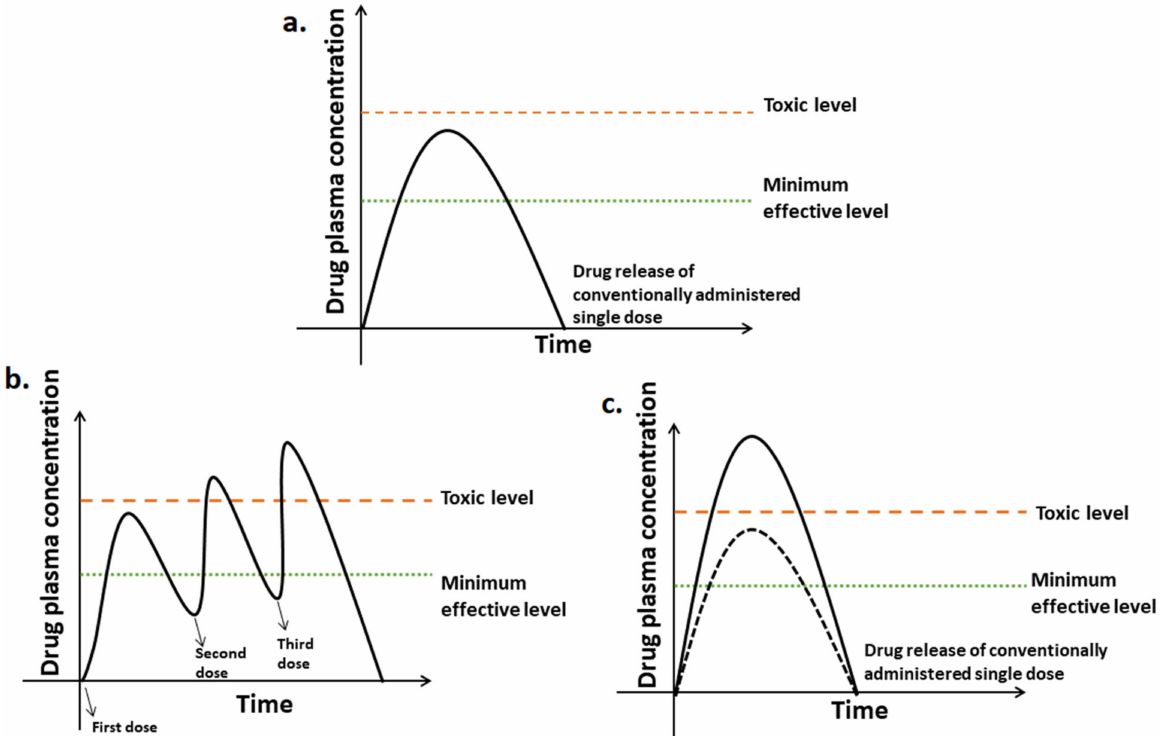
Figure 18. Plasma drug levels with time after administering ( a ) Single conventional dose, ( b ) Multiple doses, ( c ) Increased single dose.